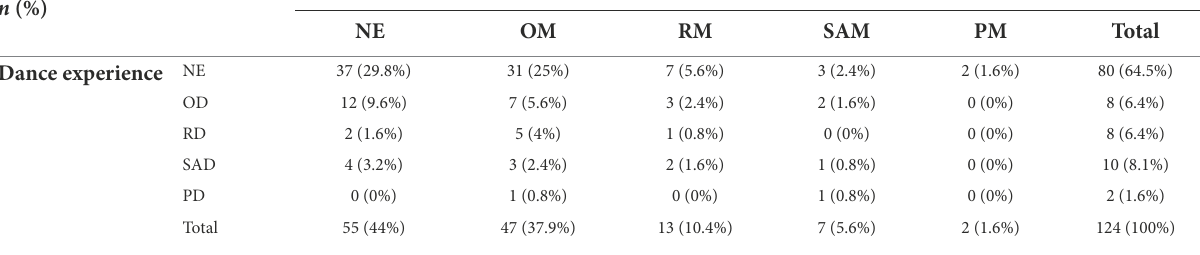
TABLE 1 Participants’ musical and dance experience: self-reported category of expertise.